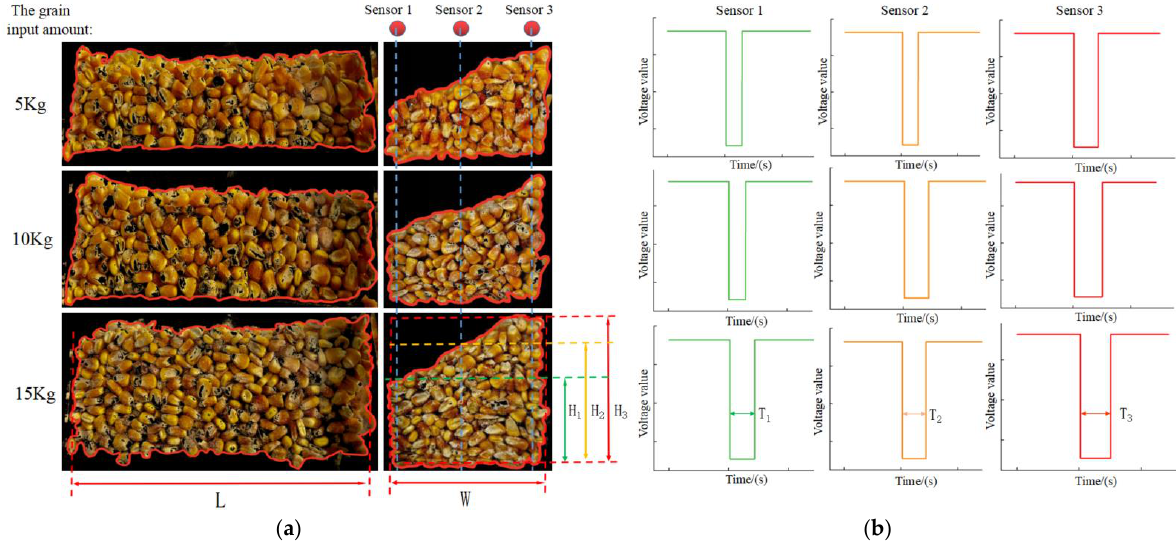
Figure 4. Different grain input feeding amount tests: ( a ) outline of grain pile shapes; ( b ) Sensor feedback signals